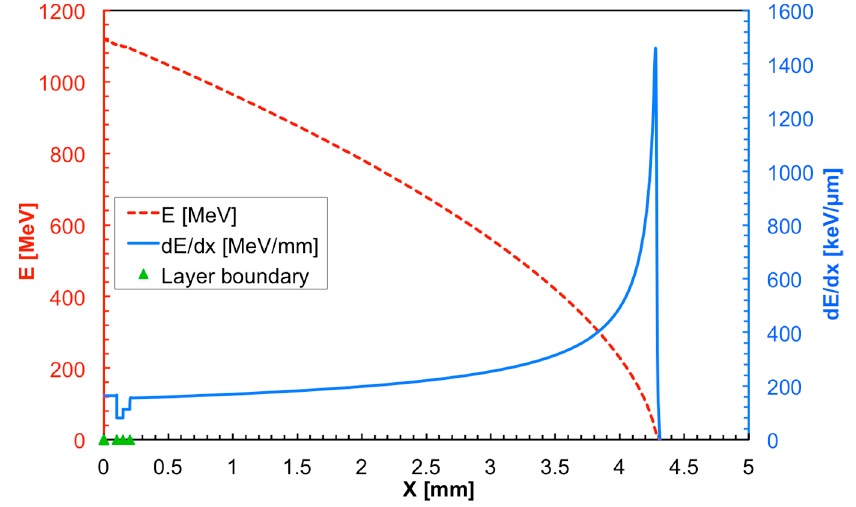
Figure 12. Energy loss profile in the telescope for an impinging 16 O ion with 70 MeV/amu kinetic